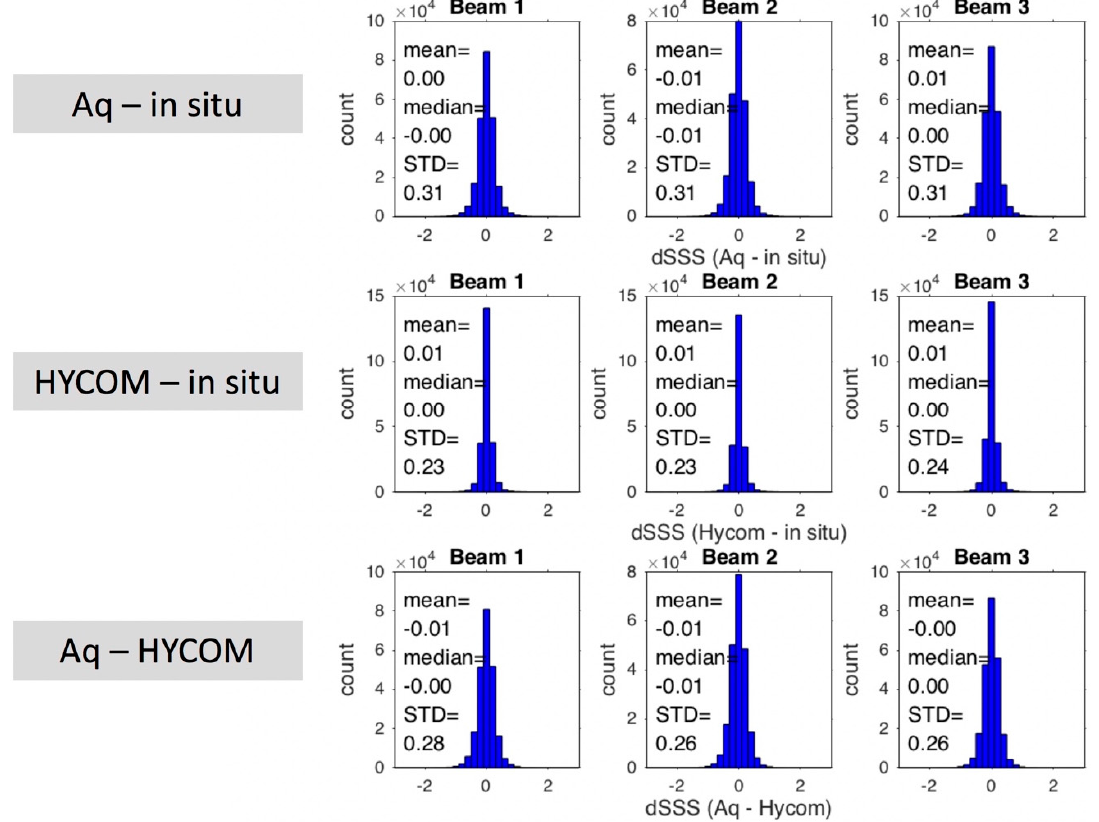
Figure 8. Co-located difference histograms for each beam of Aquarius L2 data. ( top ) Aquarius—in situ, ( middle ) Hybrid Coordinate Ocean Model (HYCOM)—in situ, ( bottom ) Aquarius—HYCOM.